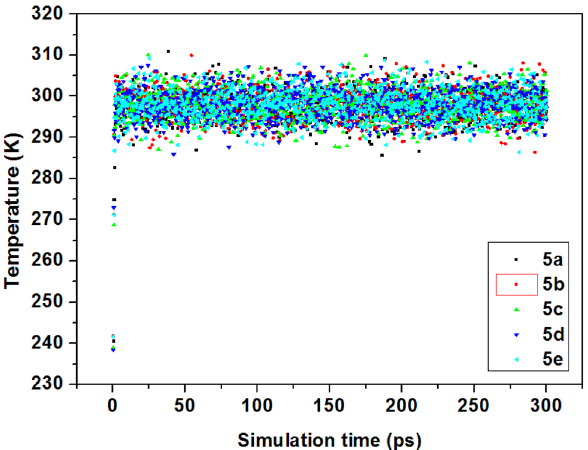
Figure 12. Temperature equilibrium curves obtained from MD simulations for 5a – e .